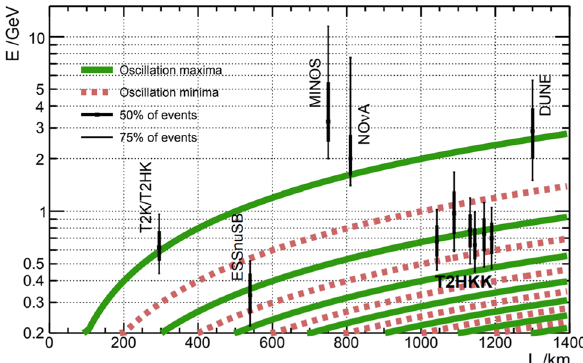
Fig. 13 Comparison of energy and baselines of various accelerator driven long-baseline experiments. The various lines for T2HKK repre- sent different possible baselines, all focusing on the second oscillation maxima. Figure from